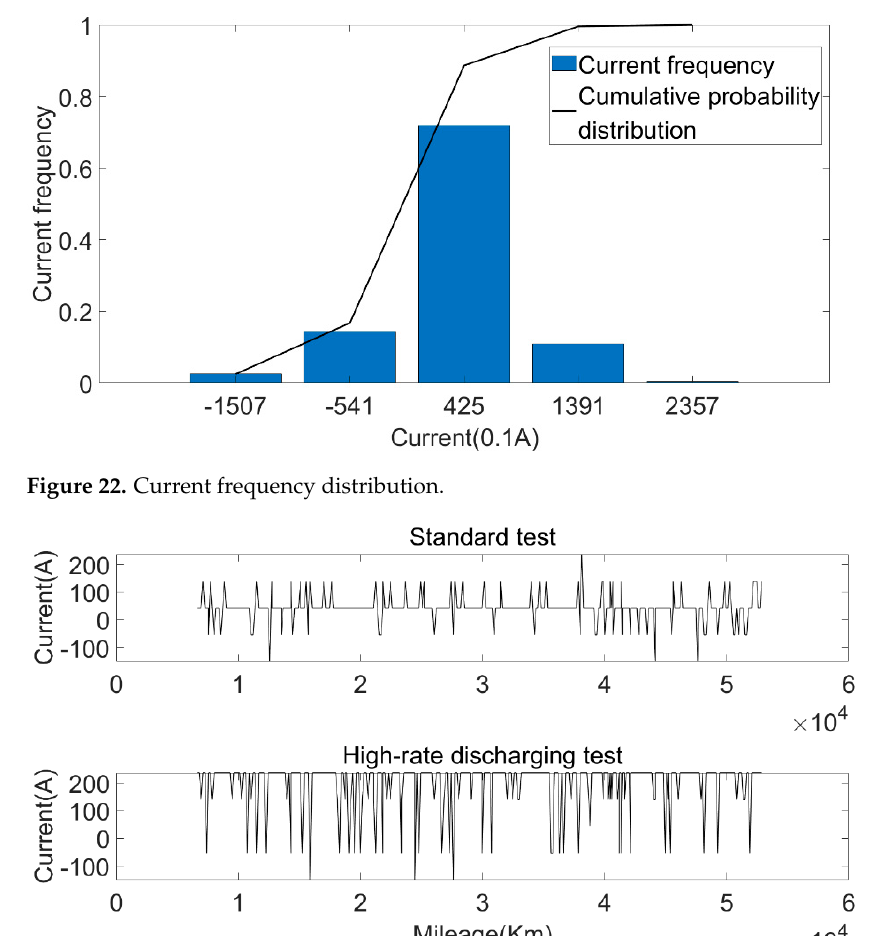
Figure 25. RUL calculation results of battery under different test environments.